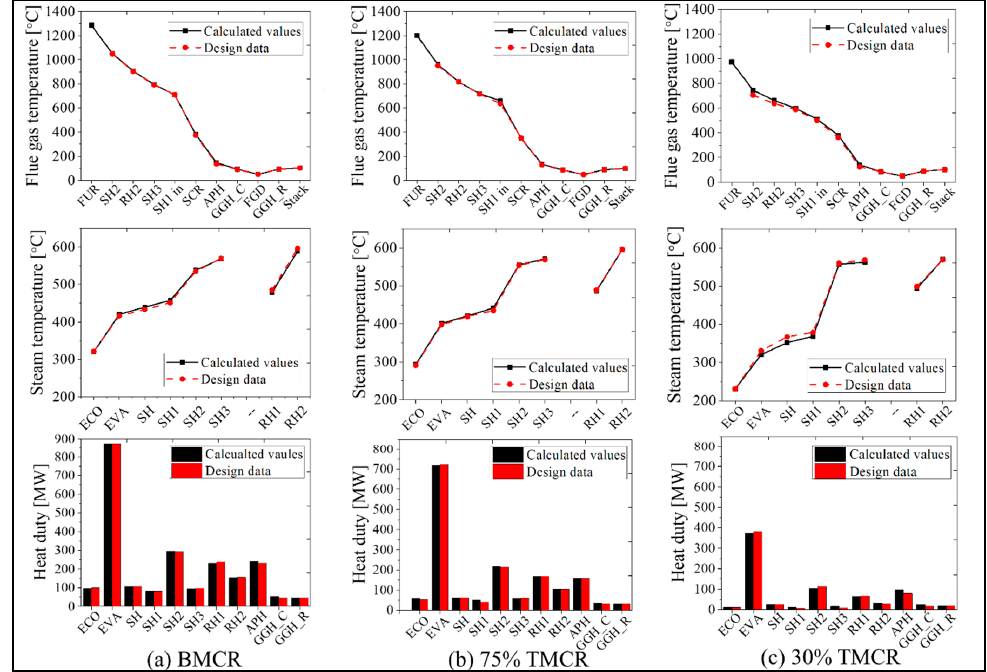
Figure 7. Representative simulation results (flue gas temperature, steam temperature, and heat duty) for mass and heat balances in the target power plant system, using the load conditions: ( a ) BMCR, ( b ) 75% Turbine Maximum Continuous Rating (TMCR), and ( c ) 30% TMCR (black color indicates calculated values, red color indicates design data).